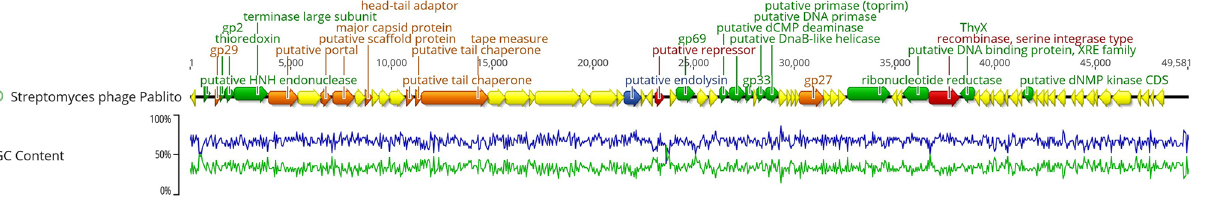
Figure 2. Schematic representation of the dsDNA genome of Streptomyces phage Pablito. Arrowheads are indicated in the direction of the CDS. Hypothetical proteins are displayed in yellow and the color code for predicted proteins is as follows: green for nucleotide metabolism and DNA replication, orange for morphogenesis, red for lysogeny and dark blue for bacterial lysis. The green line represents AT content, while the blue line represents GC content. The genome map was generated through Geneious Prime 2020 1.2.